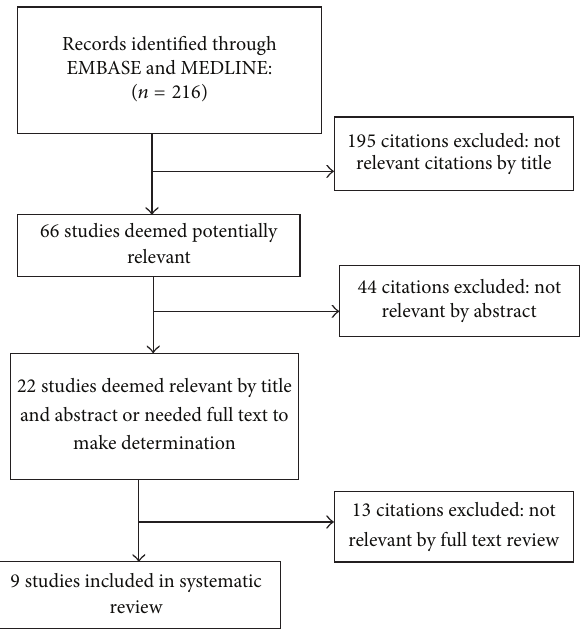
Figure 1: Flow diagram of selection of NMO incidence and